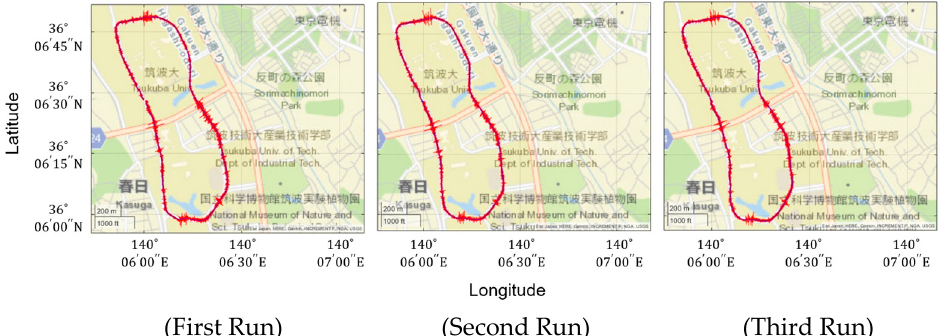
Figure 4. The measured vehicle vibration and position data .